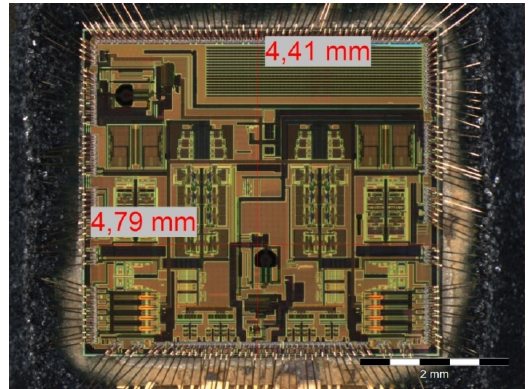
Figure 3. Picture of the acid-etched device under test (DUT) with exposed die and dimensions.